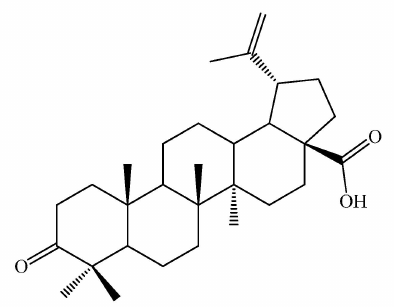
Figure 1. Structural formula of betulonic acid